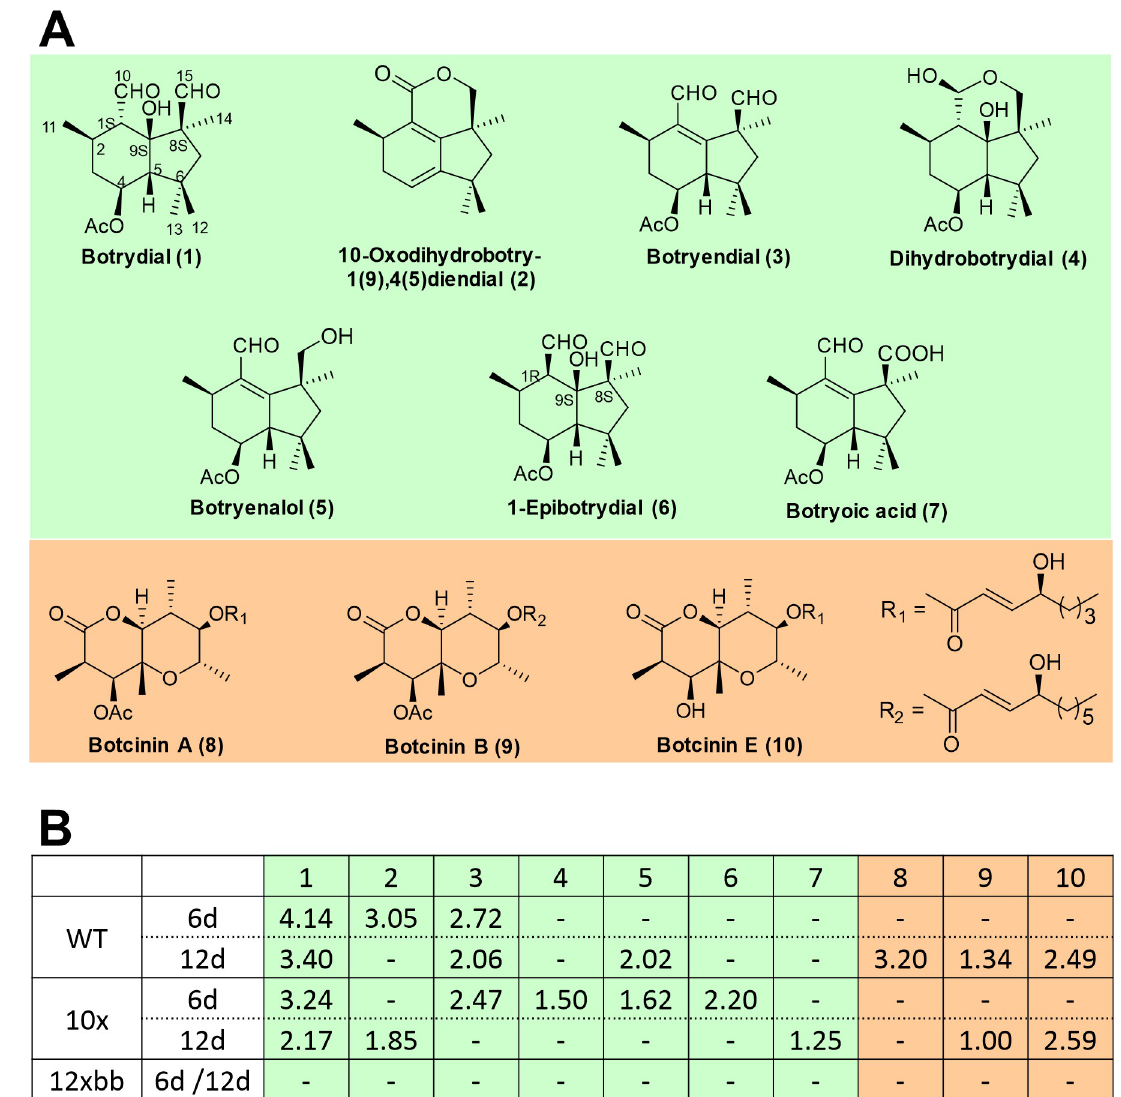
Fig 6. Production of botryanes (including botrydial) and botcinins by B . cinerea and multiple knockout mutants. A: Structures of botryanes and botcinins detected. B: Metabolite yields (in mg) obtained after 6 d and 12 d of fermentation by B . cinerea WT and 10x mutant, but not by the 12xbb mutant. -: Not